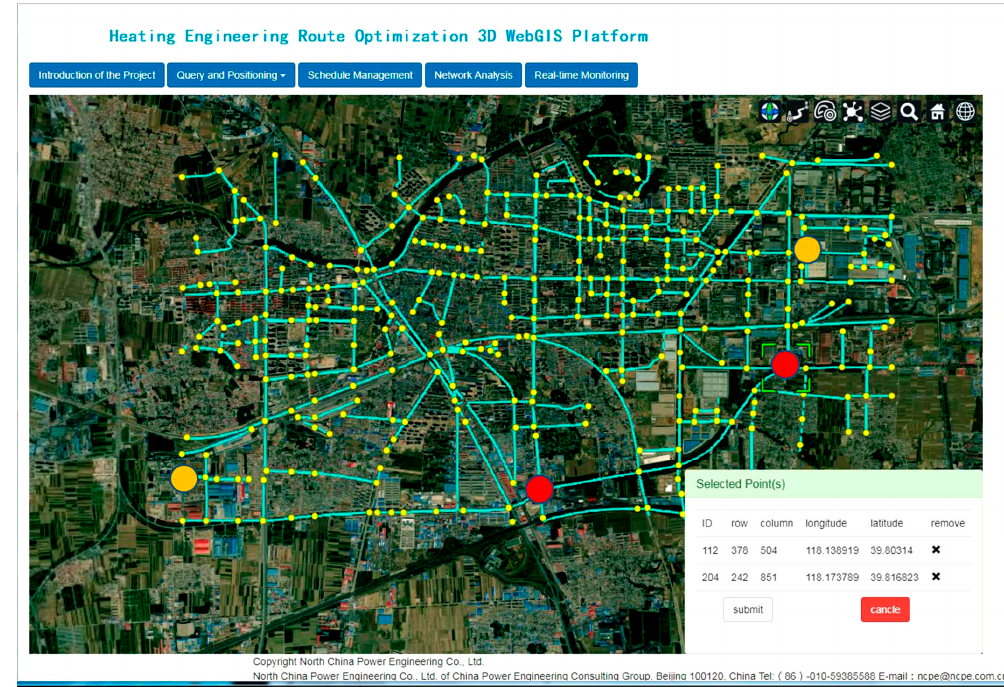
Figure 6. The interactive design interface by assigning the mandatory passed nodes (red points).